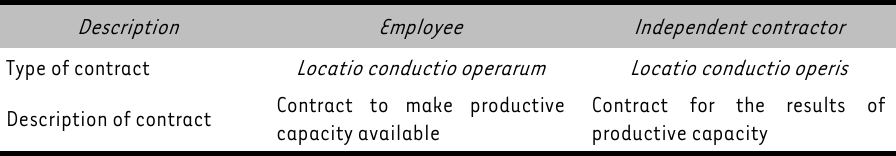
TABLE 2: Main differences between types of